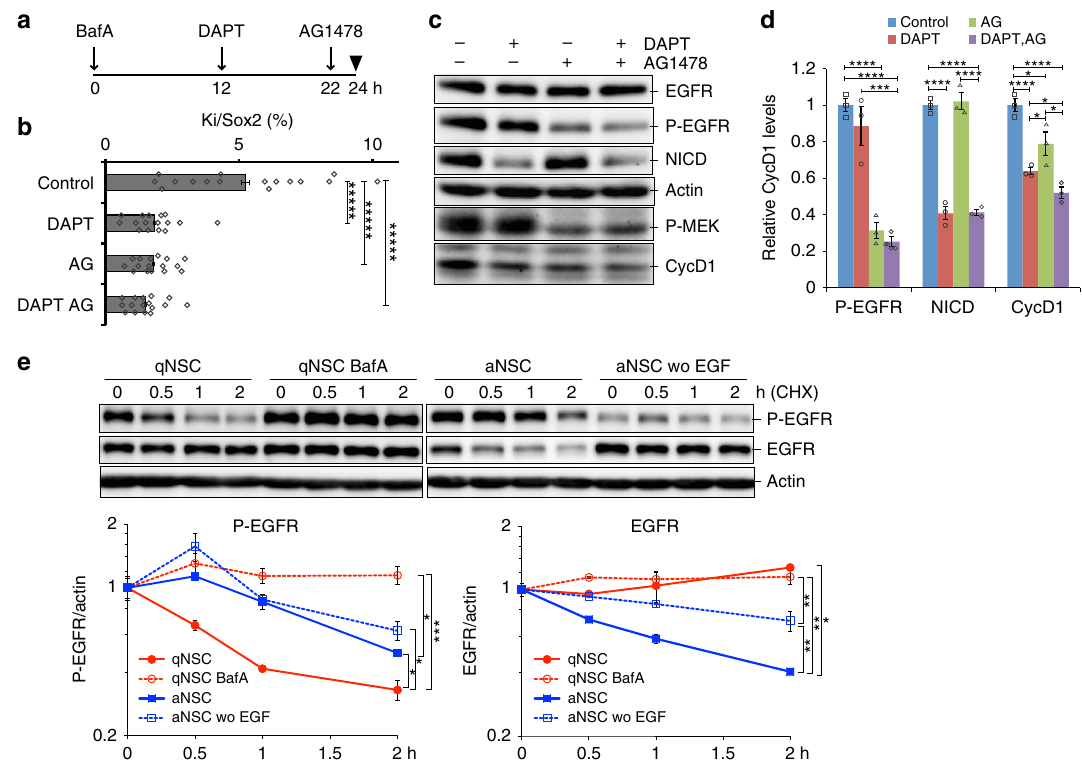
Fig. 3 Regulation of EGF and Notch signaling in qNSCs with defects in lysosomal function. a Cells were incubated for the indicated times with inhibitors of Notch (DAPT) and EGF signaling (AG1478) after BafA treatment at t = 0 h. qNSCs were cultured with 10 µ M DAPT from t = 12 h (arrow), 5 µ M AG1478 from t = 22 h (arrow), or both inhibitors in the presence of 20 nM BafA, and then analyzed at t = 24 h (arrowhead). DAPT required a longer incubation time than AG1478 to reduce the NICD level. b Percentage of Ki-67 – positive cells in Sox2-positive cells. c Representative immunoblots of qNSCs after incubation with inhibitors in the presence of BafA. d Relative protein levels of P-EGFR, NICD, and CycD1 in ( c ), normalized against β -actin. e Protein stability of EGFR ( n = 2). BafA was added 4 h before all assays in lysosomal-inhibited samples. Activated EGFR (P-EGFR) and total EGFR (EGFR) in immunoblots were quanti fi ed and plotted (lower panels). Left panel: qNSCs degrade P-EGFR (red closed circles) more rapidly than aNSCs (blue closed squares), but the protein was stabilized in the presence of BafA (red open circles). Total EGFR degradation depended on the presence of EGF (blue squares). Data represent means ± s.e.m. (* P < 0.05, ** P < 0.01, *** P < 0.005, **** P < 0.001, ***** P < 0.0001; Student ’ s t -test). Source data of immunoblots are provided as a Source Data fi